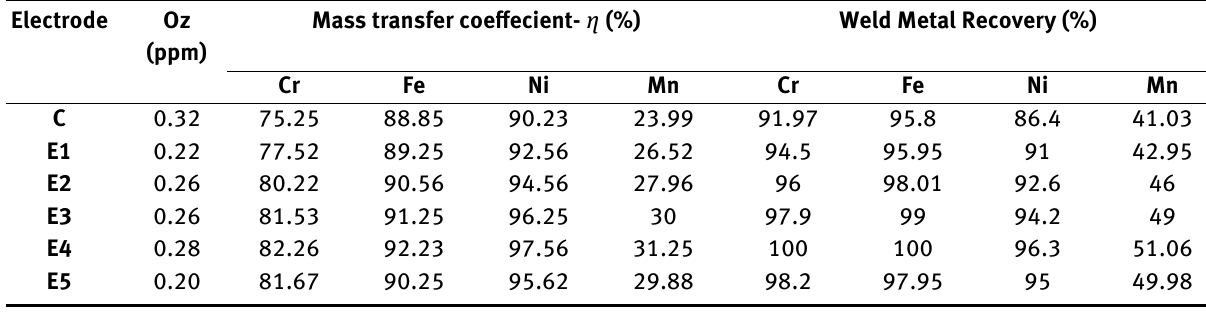
Table 3: Ozone concentration of fumes, mass transfer coeflcient and weld metal recovery during welding Electrode